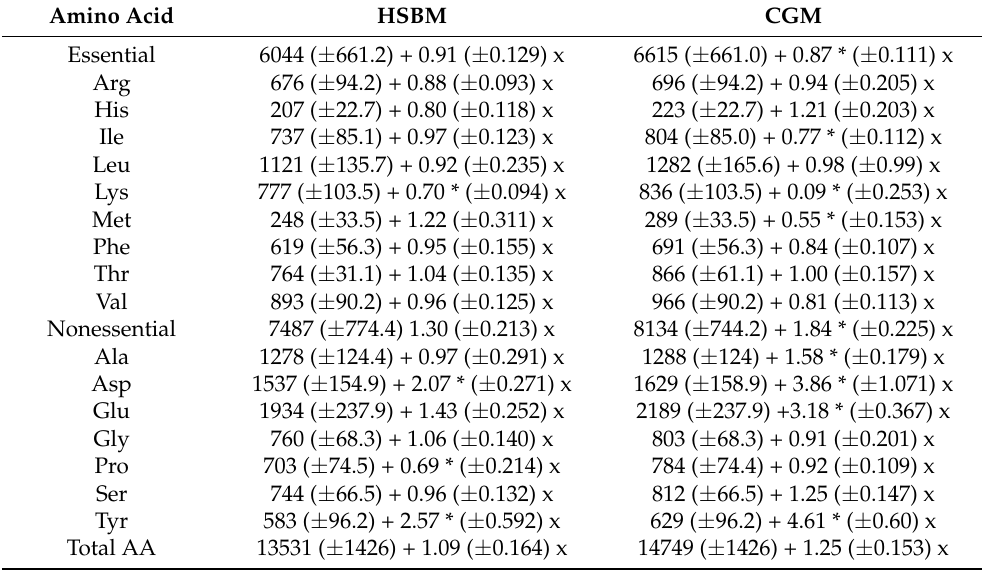
Table 6. Prediction equation of the flow of individual AAs (mg) from the dual-flow continuous culture fed diets with increasing amounts of heat-treated soybean meal (HSBM) and corn gluten meal (CGM). The linear term (x) is the amount of AA (mg) supplied from the protein supplement, and its coefficient represents the proportion of the individual AA from the protein supplement escaping from ruminal